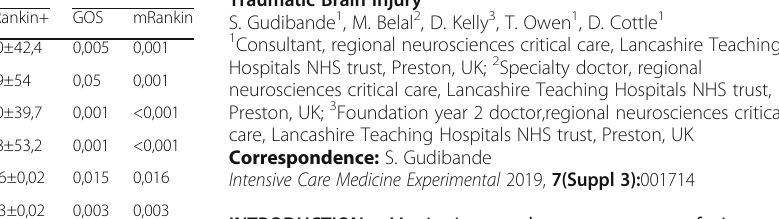
Table 2 (abstract 001615). Univariable analysis of BIB associated with mRS and GOS at ICU discharge. +Mean±SDE